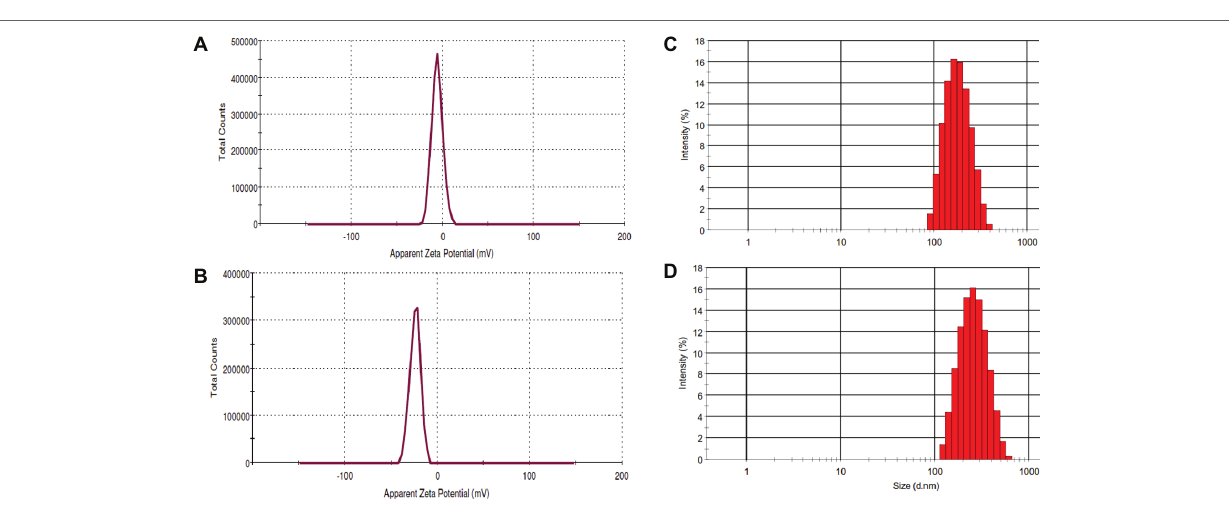
FIGURE 3 | Zeta potential of (A) hydroxyapatite (HA) and (B) hydroxyapatite– A. indica (HA-AI) composite. DLS pattern of (C) HA and (D) HA-AI